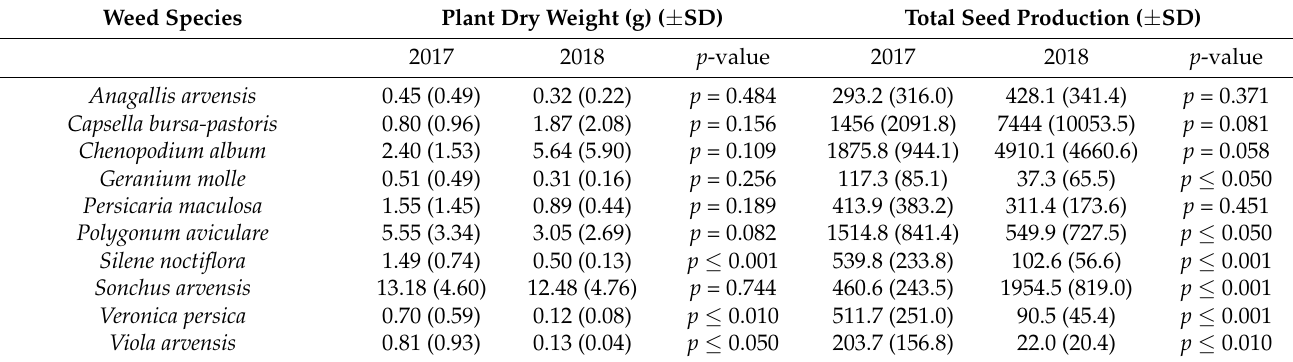
Table 1. Average plant dry weight (g) with standard deviation (SD) and total seed production (number per plant) of weed species in oat fields in 2017 and 2018. p values shown for difference between the